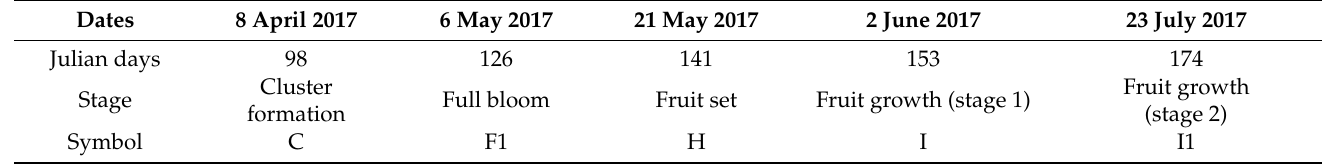
Table 1. Observed phenological stages during the growing season March–November 2017.